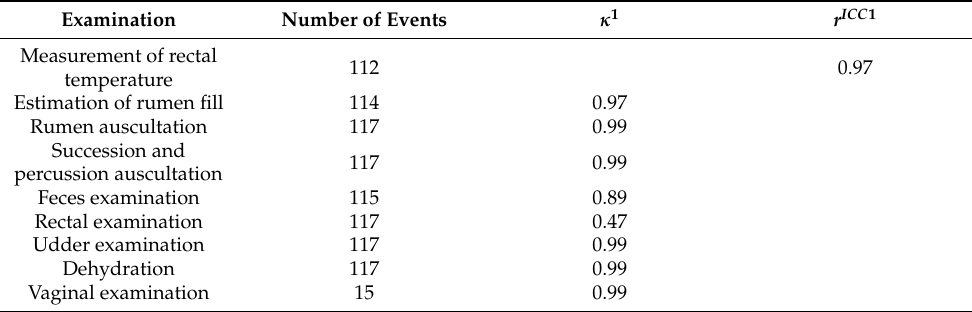
Table 3. Inter-rater reliability: three investigators (Inv1–Inv3) were compared with each other in various examinations, Cohen’s Kappa ( κ ), intraclass correlation coefficient